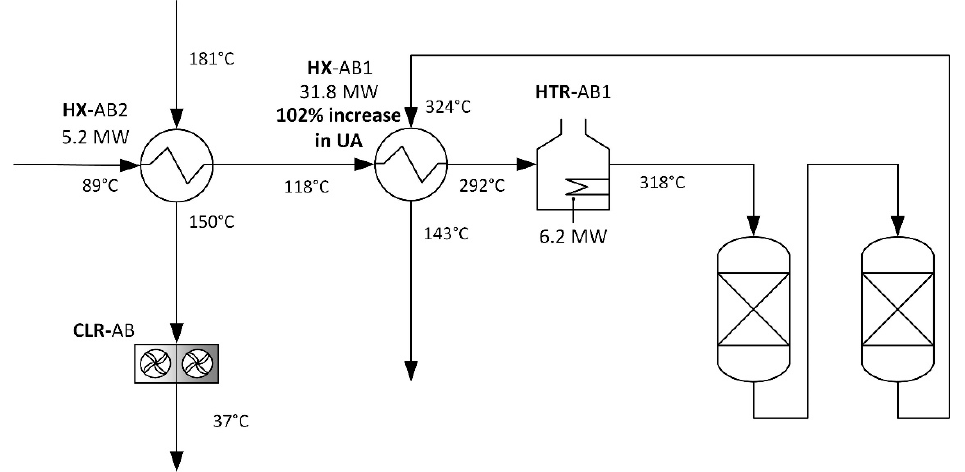
Figure A2. Retrofit proposal 1A.